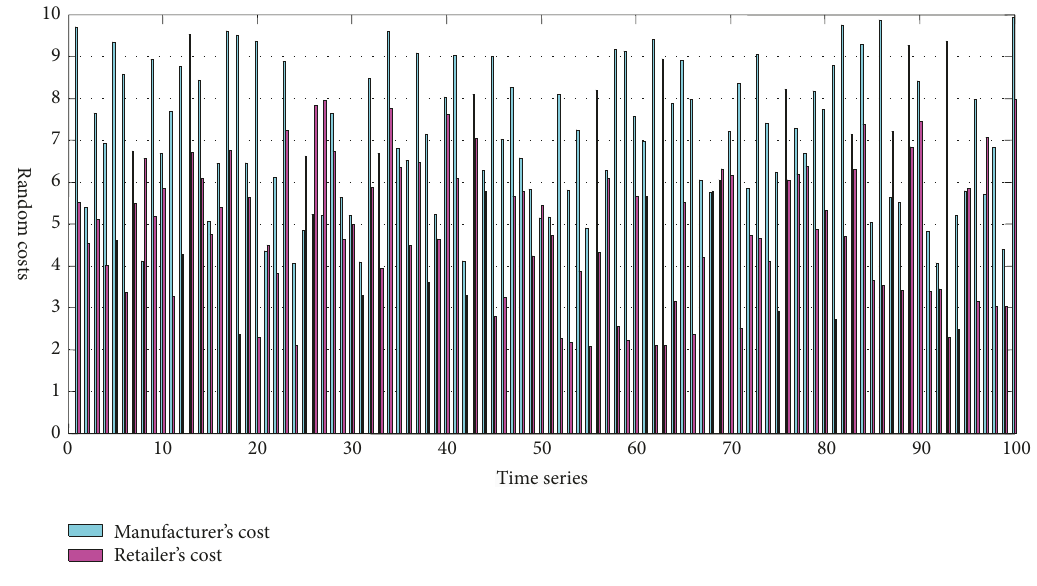
Figure 4: Random